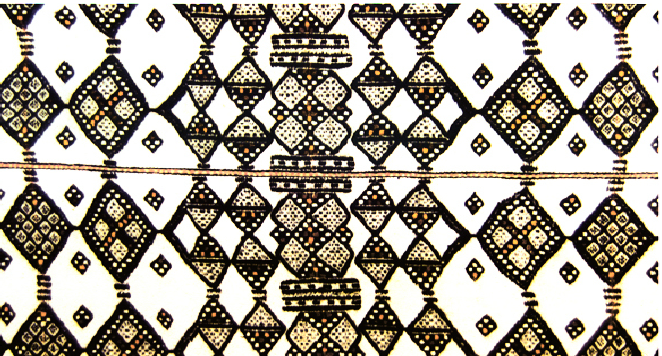
Figure 24. Fractals in a piece of African textile from Ron Eglash’s book, “ African Fractals: Modern computing and indigenous design ” available on https://roneglash.org/eglash.dir/afractal/afbook.htm (accessed on 20 October